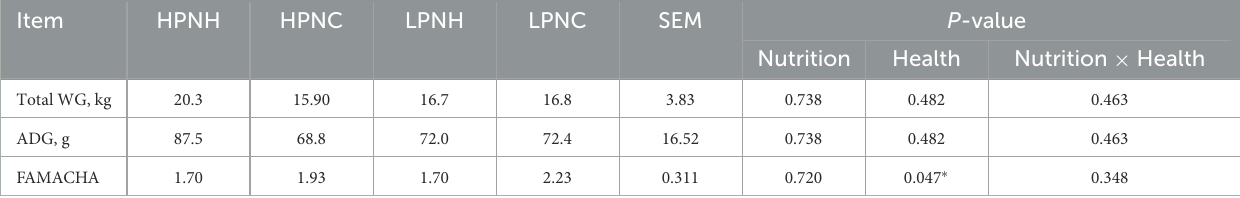
TABLE 1 Weight gain and FAMACHA score of lambs in response to the plane of nutrition and health status.